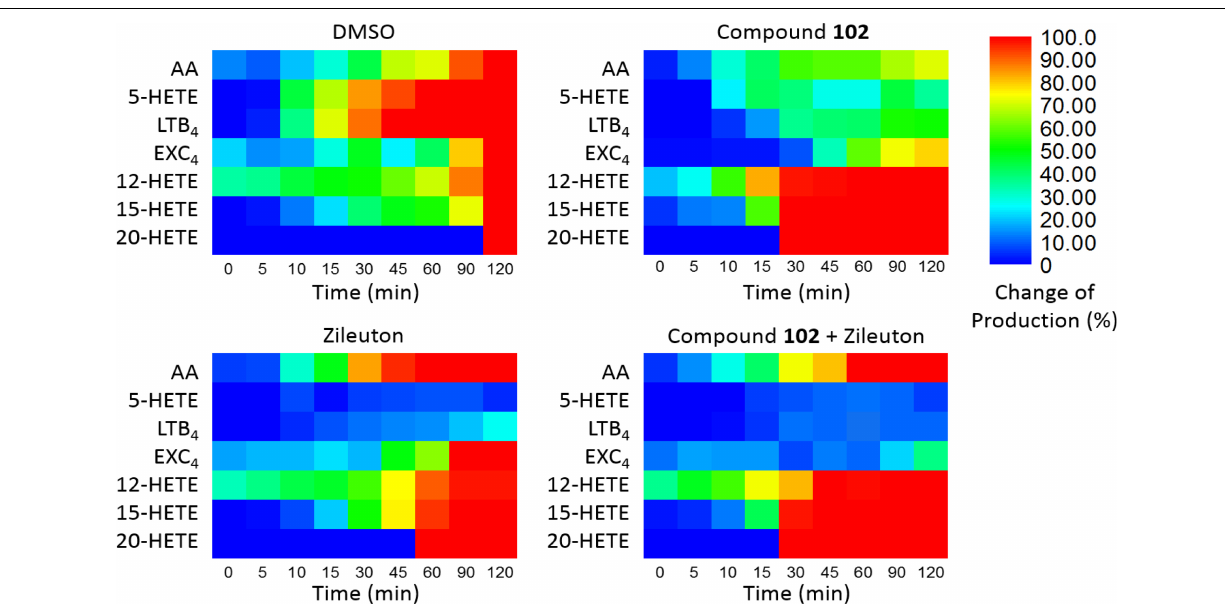
concentration to reach 150% activation was about 39.2 µ